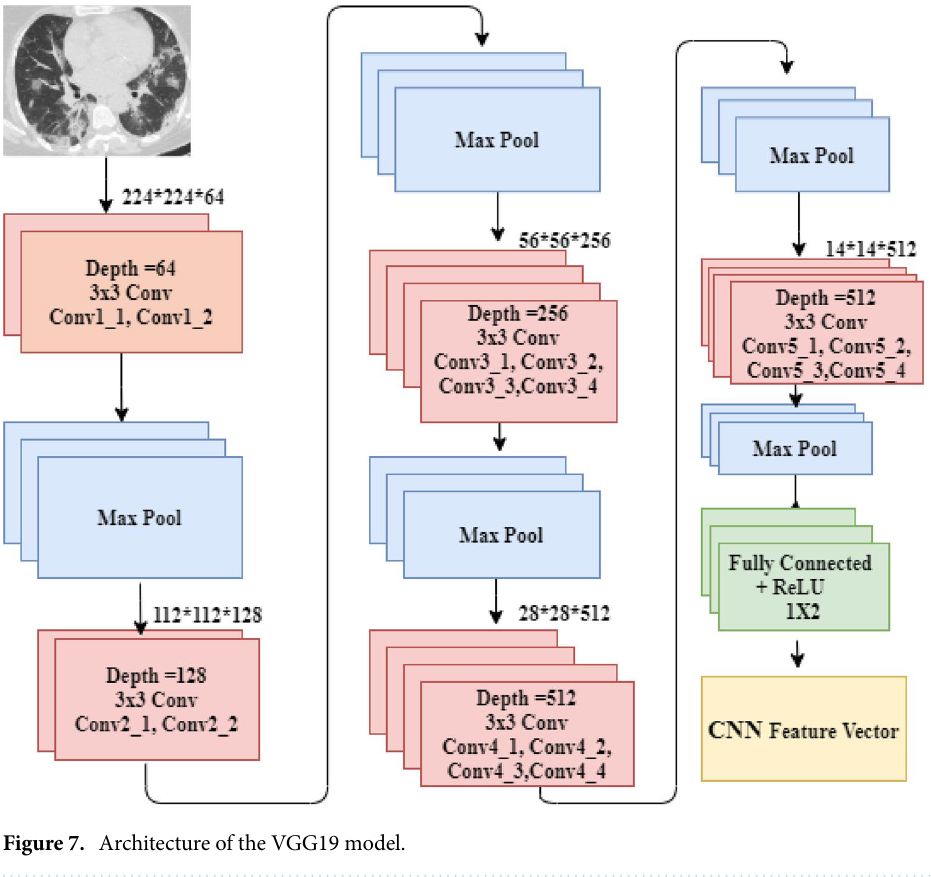
Figure 7. Architecture of the VGG19